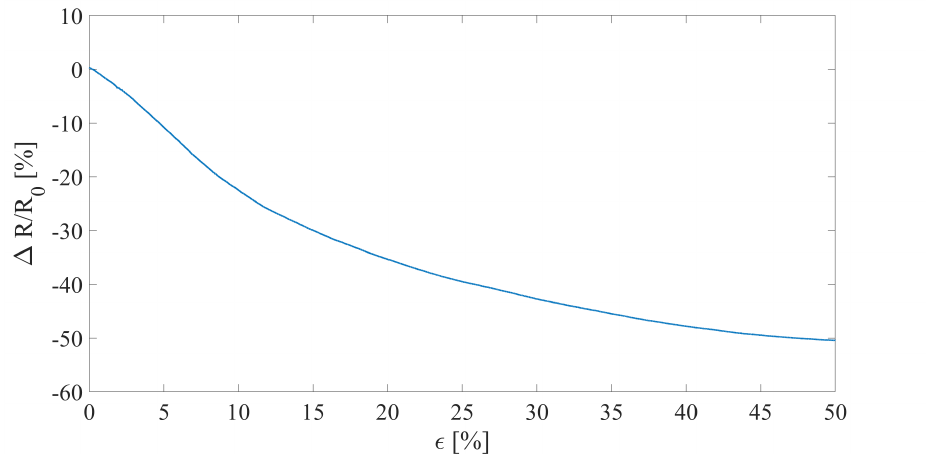
Figure 6. Relative resistance change of the fruit growth sensor when tested in a single strain test up to 50%.